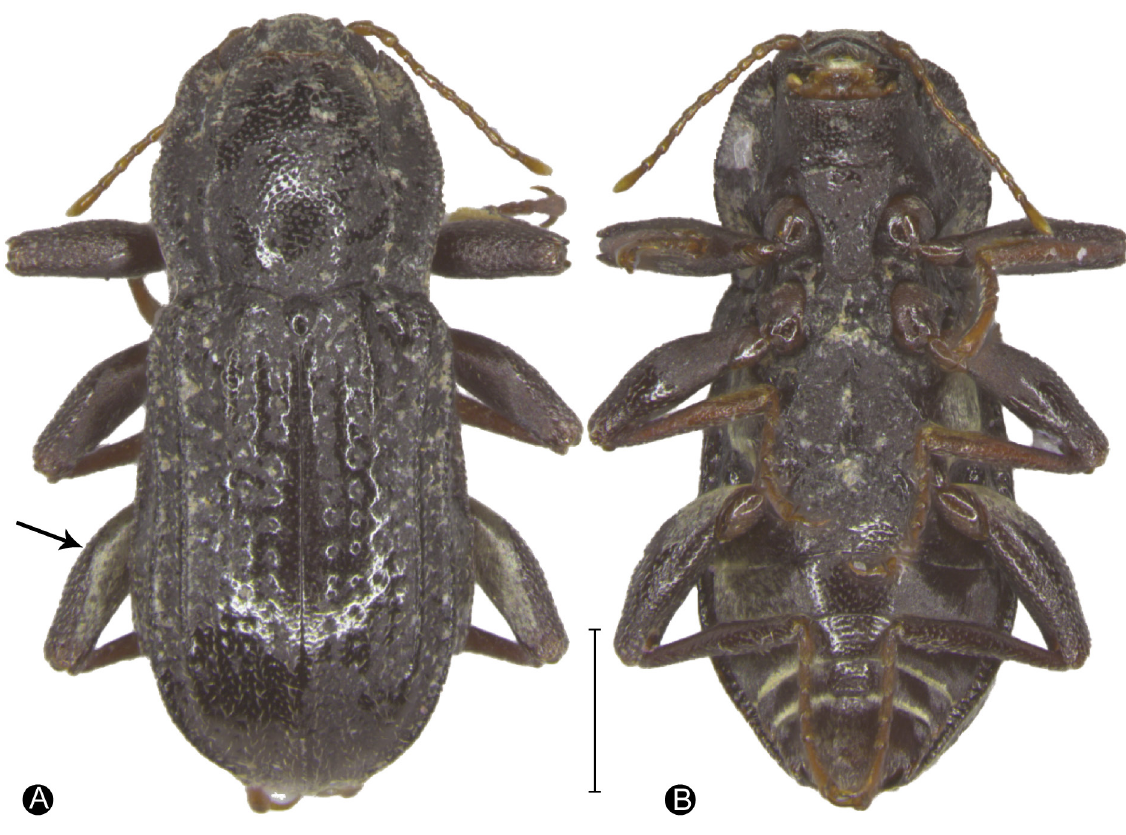
Fig. 2. Spanglerelmis xiririca Polizei & Bispo gen. et sp. nov., holotype, ♂ (MZSP31444). Habitus. A . Dorsal view (arrow showing the pattern of tomentum on femur). B . Ventral view. Scale bar = 0.5